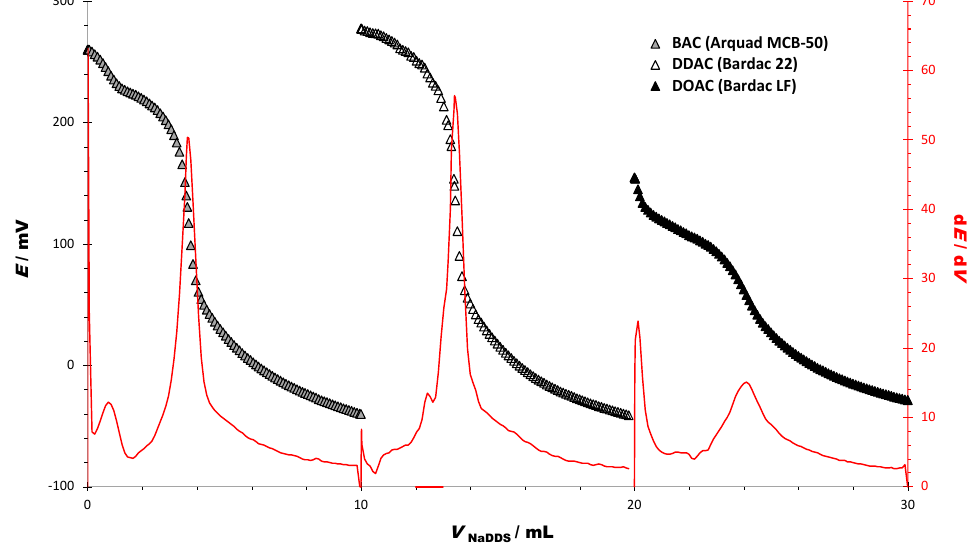
Figure 1. Potentiometric titration curves and their first derivatives of three cationic surfactants: BAC, DDAC, and DOAC using SDS as a titrant ( c = 4 mM) and DODI-TPB potentiometric sensor as an indicator.